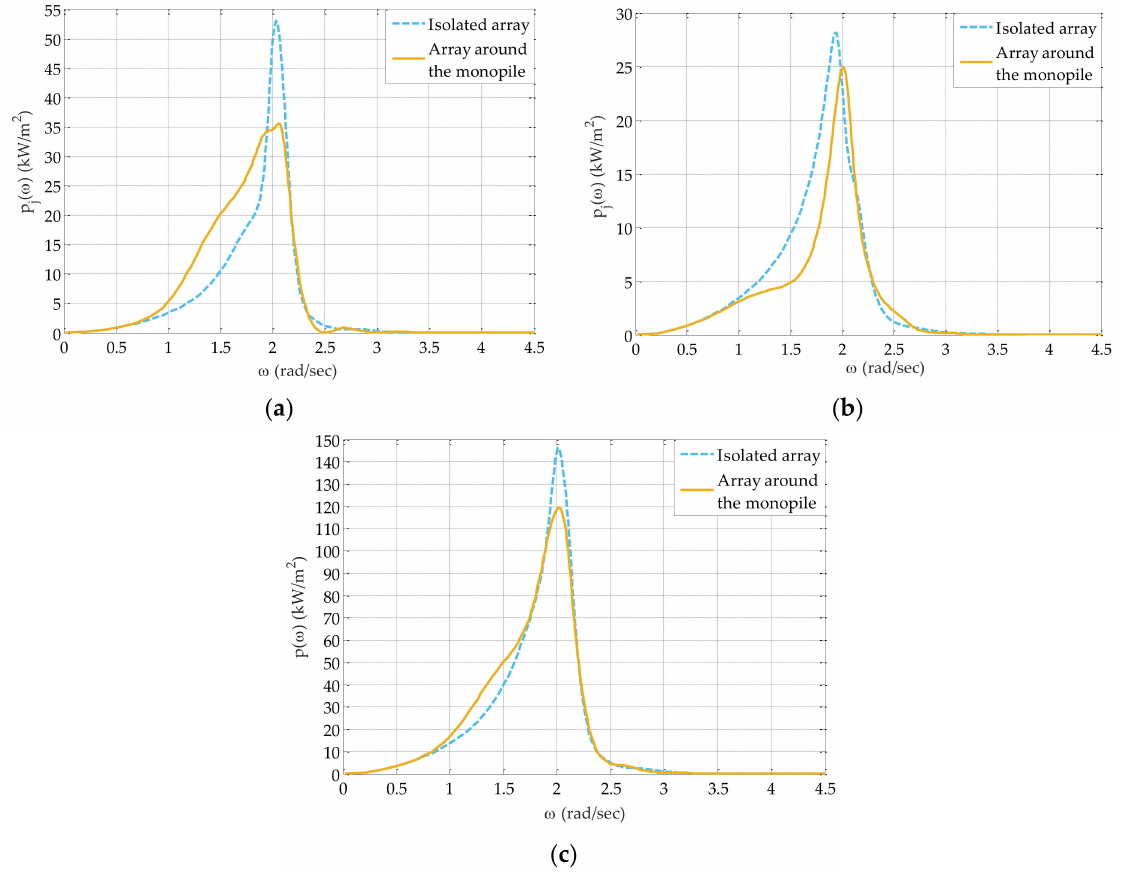
Figure 13. Comparisonof the mean power absorbed by the hemispherical-shaped WECs with and without (isolated array) the monopile for β = 0 o and d net = 0.25 r 0 : ( a ) WEC1 and WEC4; ( b ) WEC2 and WEC3; ( c ) whole